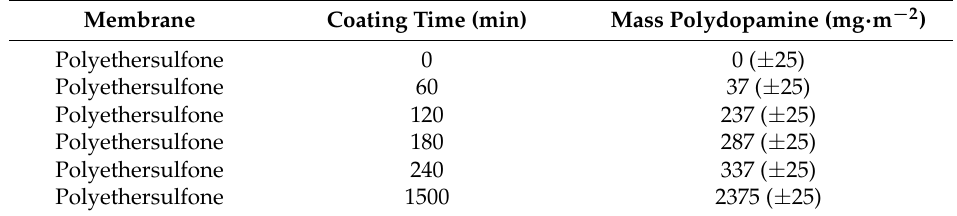
Table 1. Gravimetric analysis of polydopamine deposited on PES membranes used in this work.